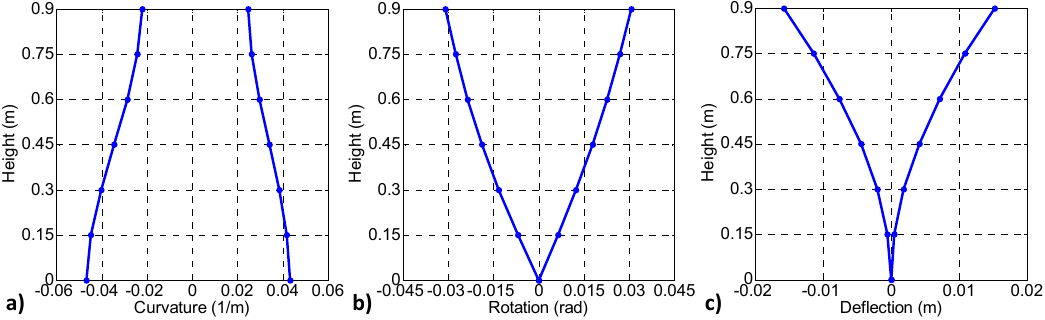
Figure 8. Residual deformation at the plastic hinge region of S-C column: ( a ) curvature, ( b ) rotation, ( c ) deflection.